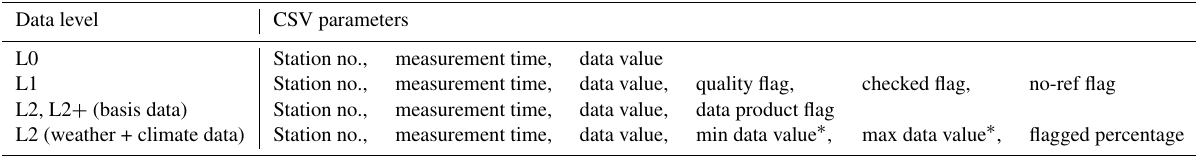
Table 7. WegenerNet CSV data format general